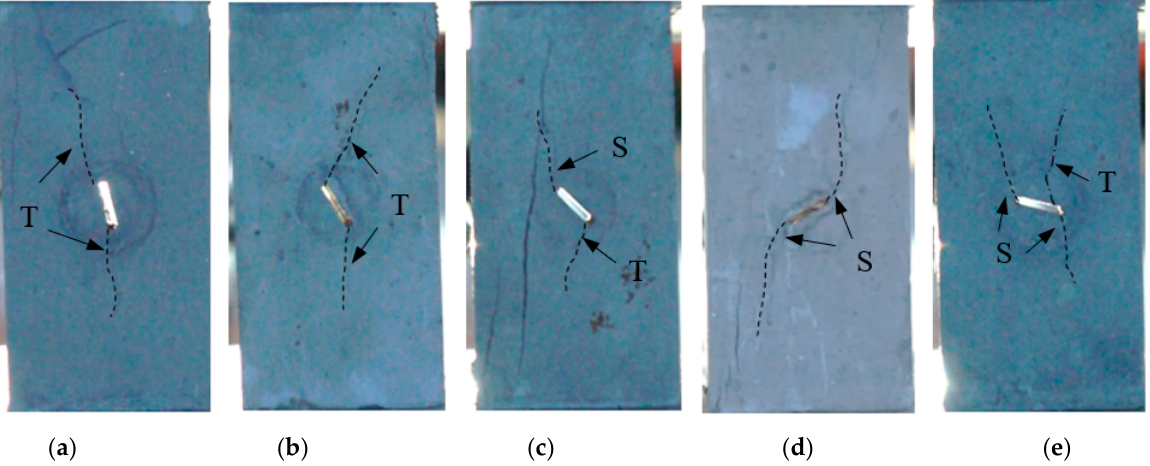
Figure 4. Failure mode of jointed concrete with a single crack (crack width = 3.0 mm). ( a ) β = 15°, ( b ) β = 30°, ( c ) β = 45°, ( d ) β = 60°, ( e ) β = 75° Note: T represents tensile crack and S represents shear crack.